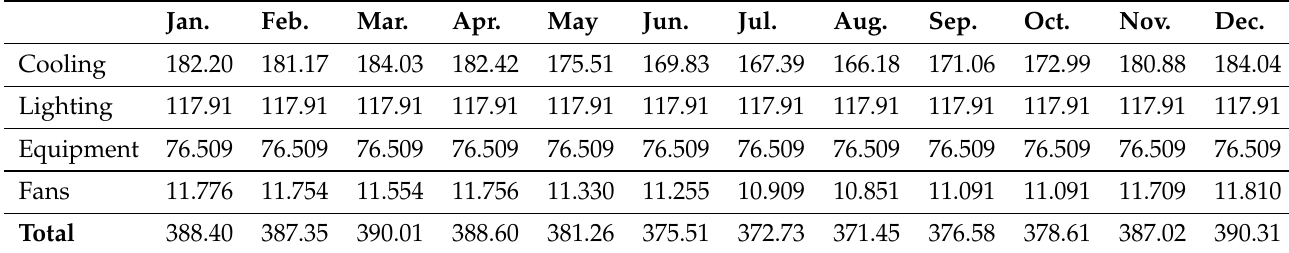
Table 1. Annual electricity Peak Demand